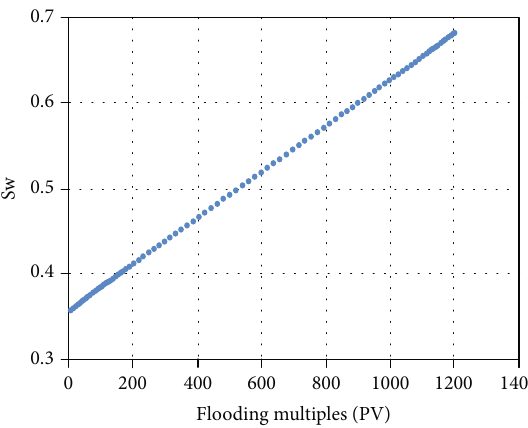
Figure 5: The relationship between S